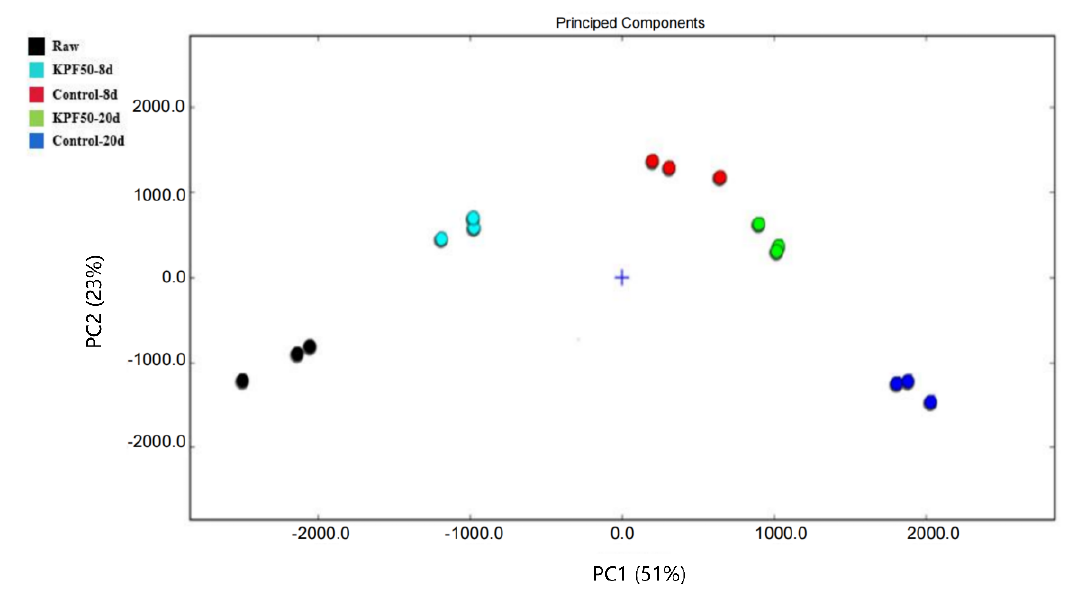
Figure 5. PCA analysis of sea bass fillets samples.